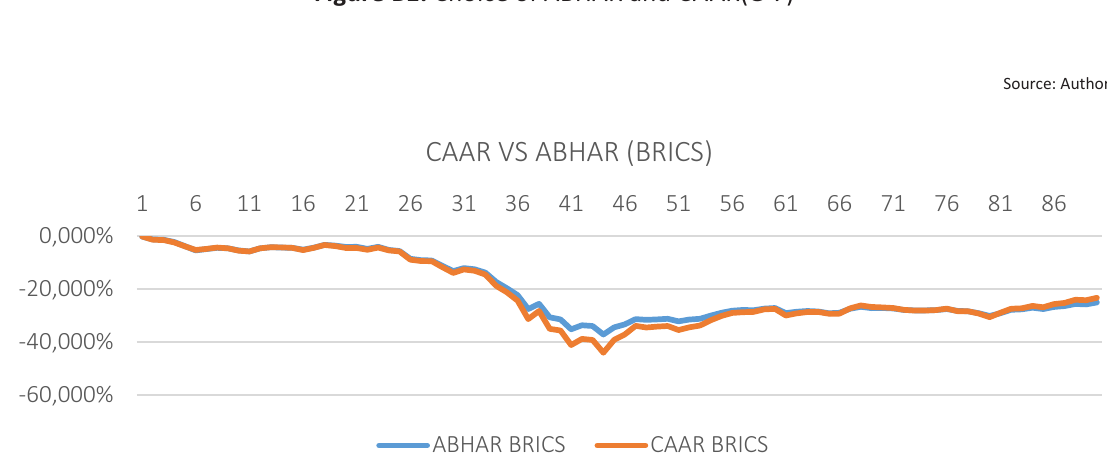
Figure B1. Choice of ABHAR and CAAR(G-7)